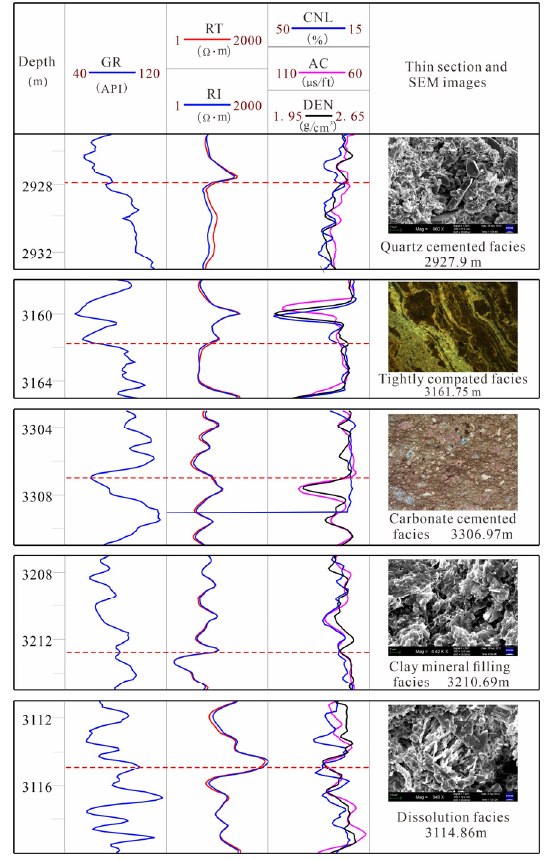
Figure 10. Characteristics of different diagenetic facies logging curves and corresponding thin sections and SEM images.